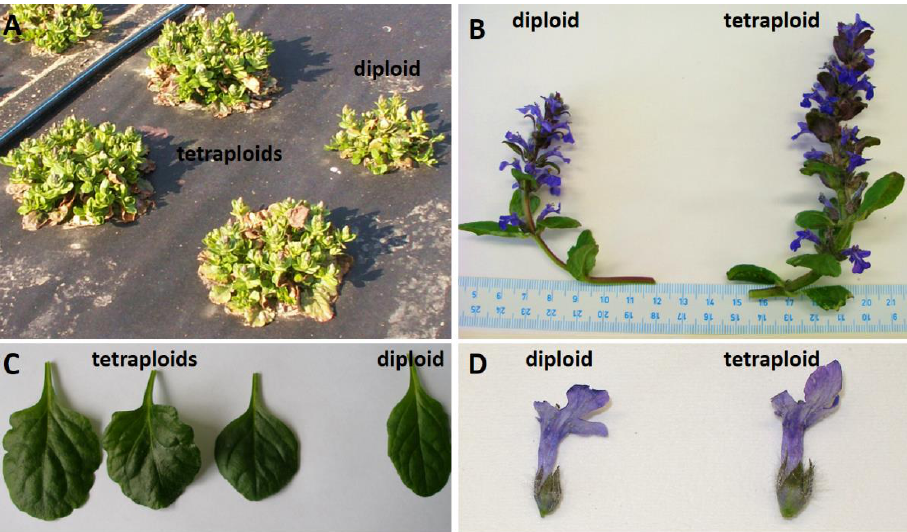
Figure 1. Differences between diploid and tetraploid plants of A. reptans . ( A ) Tetraploid plants displayed more robust growth than diploid plants in field conditions, even though they were planted at the same time. ( B ) Sizes of diploid and tetraploid plants at the maximum flowering stage. ( C ) Leaf size and shape of tetraploid and diploid plants. Leaves were collected from the basal part of shoots. ( D ) Tetraploid flowers were bigger than diploid ones. Flowers and shoots flowering were collected at the same